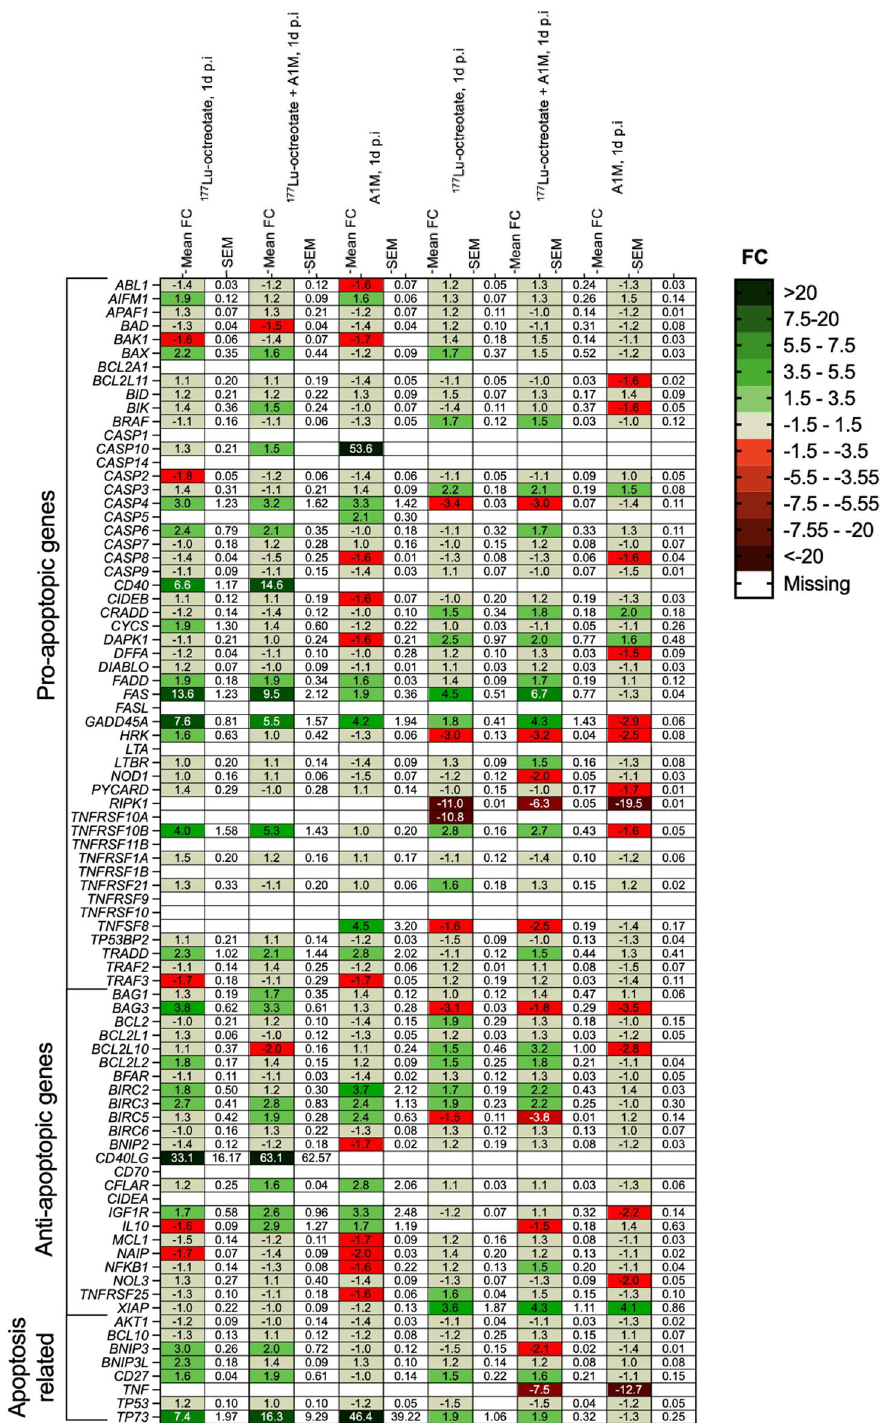
Figure 1. mRNA expression of apoptosis related genes in GOT1 tumor tissue of mice injected with 177 Lu-octreotate, 177 Lu-octreotate + A1M, or A1M collected at 1 and 7 days after treatment (left to right). Gene regulation is expressed as fold change relative to the control group (FC) and reported as mean and SEM. Three and two animals with GOT1 tumors are included in each treatment group and controls, respectively, at both 1 and 7 days after study start. Red and green shades represent down- and upregulation, respectively, with more than 1.5-fold expression. Grey color indicates regulation less than 1.5-fold expression. Missing data in all tumors is represented by white color. Statistical analysis was performed using Perseus software 1.6.15.0 (https:// maxqu ant. net/ perse us/) and the figure was produced using GraphPad Prism version 9.3.1 (https:// www. graph pad. com/ scien tific- softw are/